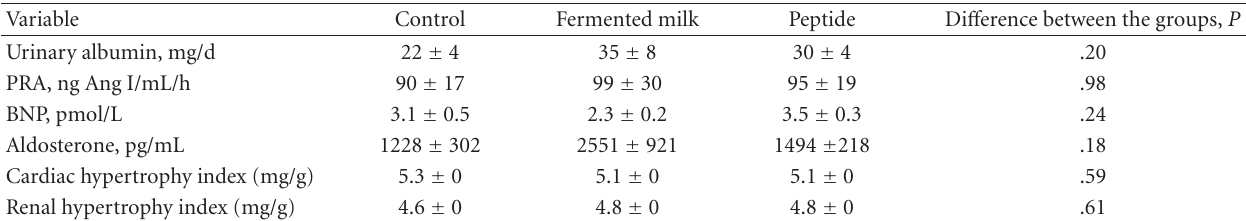
Table 2: Biochemical variables and cardiac and renal hypertrophies at the end of the three-week treatment period (mean ± SE, n = 6 – 9). Variable Control Fermented milk Peptide Di ff erence between the groups, P Urinary albumin,